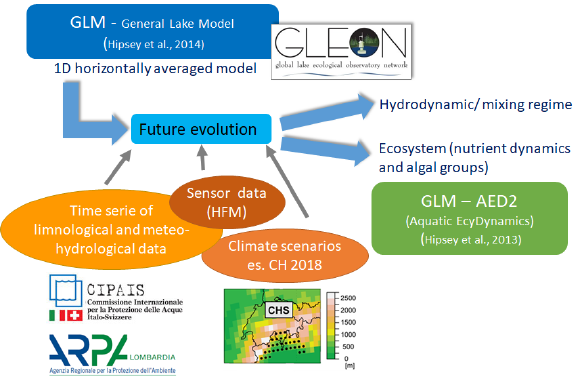
Figure 4. Modelling approach adopted in the SIMILE